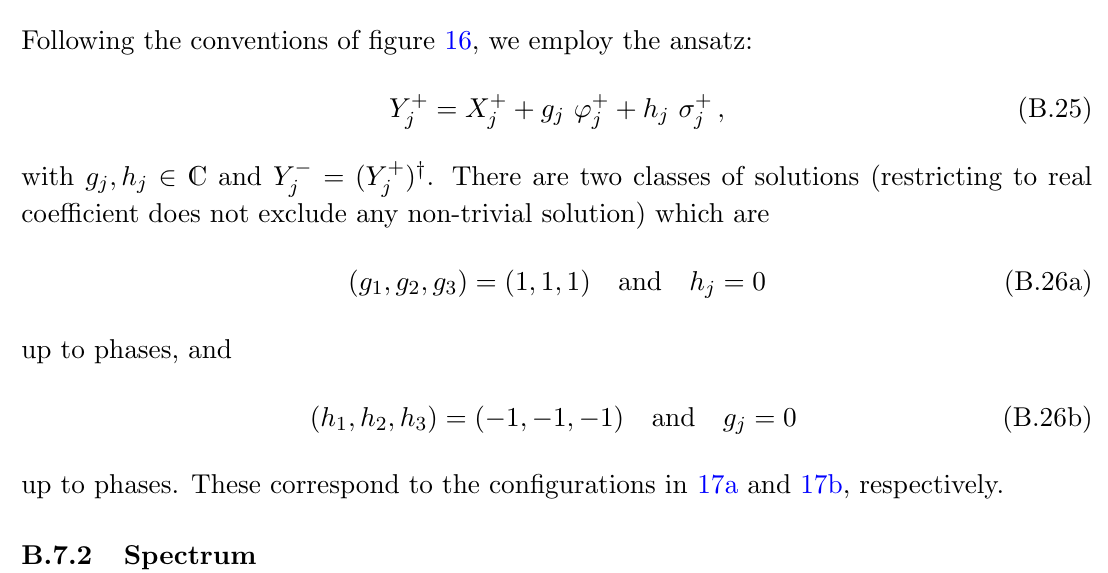
Figure 33. (a) The number of negative and zero modes of O X branes with several Higgs modes as background. (b) The number of negative and zero modes of O X for the C [(1 ; 1)] brane with rank 2 Higgs modes as background. The red dashed vertical lines V indicates M (cid:3)